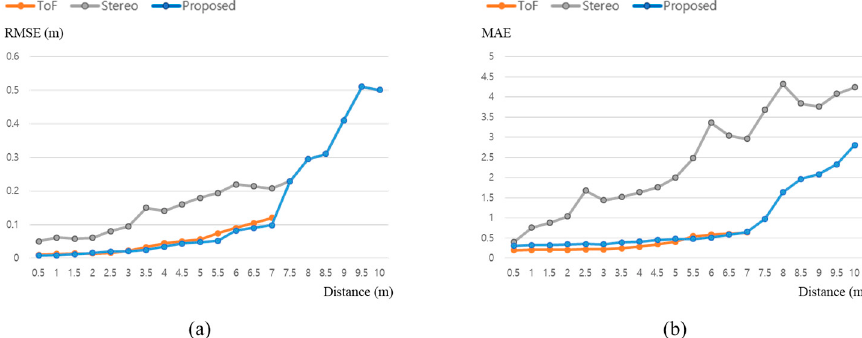
Figure 6. Experimental result of accuracy by distance: ( a ) RMSE; ( b ) MAE. Table 1. Result of accuracy test by distance.